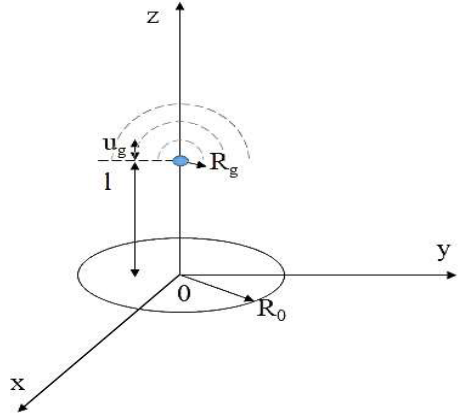
Figure 1. Monopole ultrasonic model at the tip of needle.